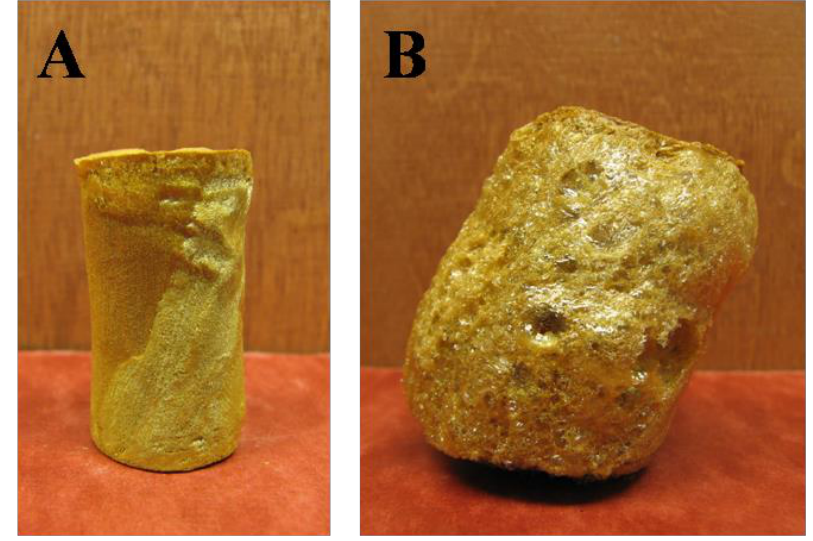
Figure 6. Image of 5 wt.% Torlon ® AI-50 materials with ( A ) 6 and ( B ) 10 equivalents of amine.